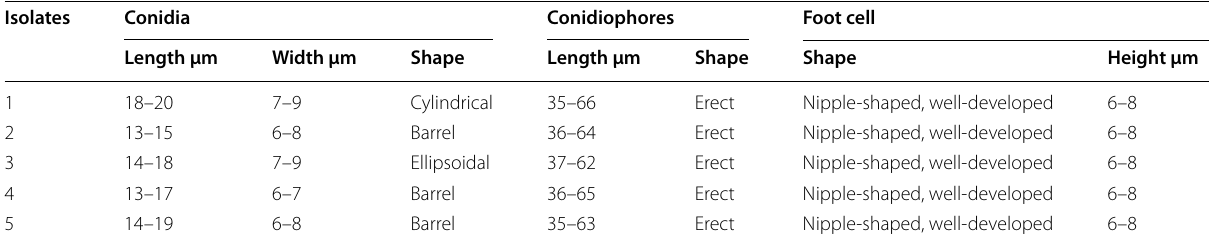
Table 2 Dimensions and shapes of conidia, conidiophores and foot cell of different isolates of the causal agent of sunflower powdery mildew collected from different Governorates Isolates